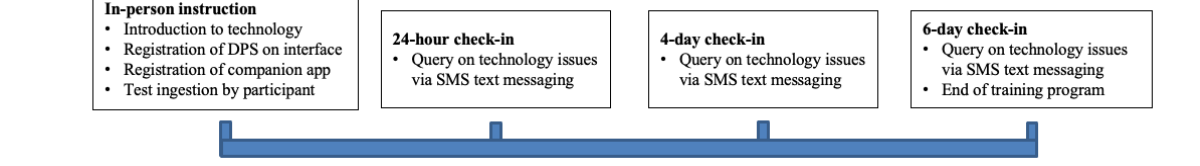
Figure 1. Overall structure of the digital pill system training program in-person session and remote follow-up. DPS: digital pill